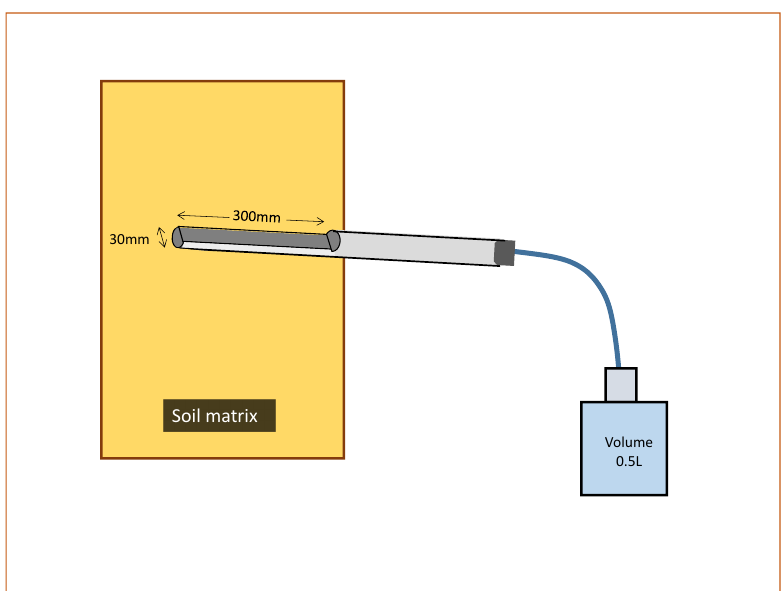
Figure 3. Design of lysimeter for collecting soil-percolating